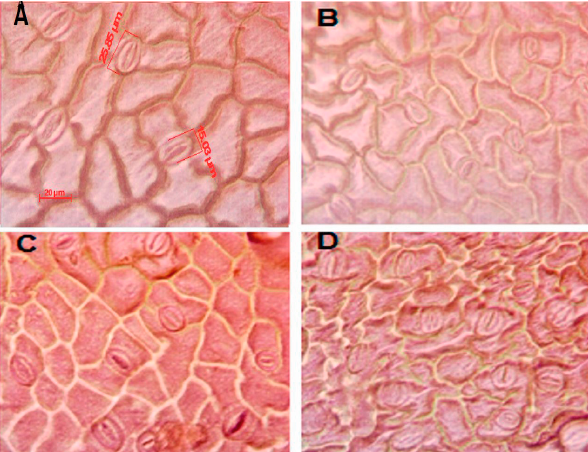
Figure 1. Distribution and size of stomata. The adaxial leaf surface with ( A ) and without ( B ) grafting. The abaxial side of leaves from grafted ( C ) and non-grafted ( D ) plants treated with Cs-PVA-nCu. Scale bar, 20